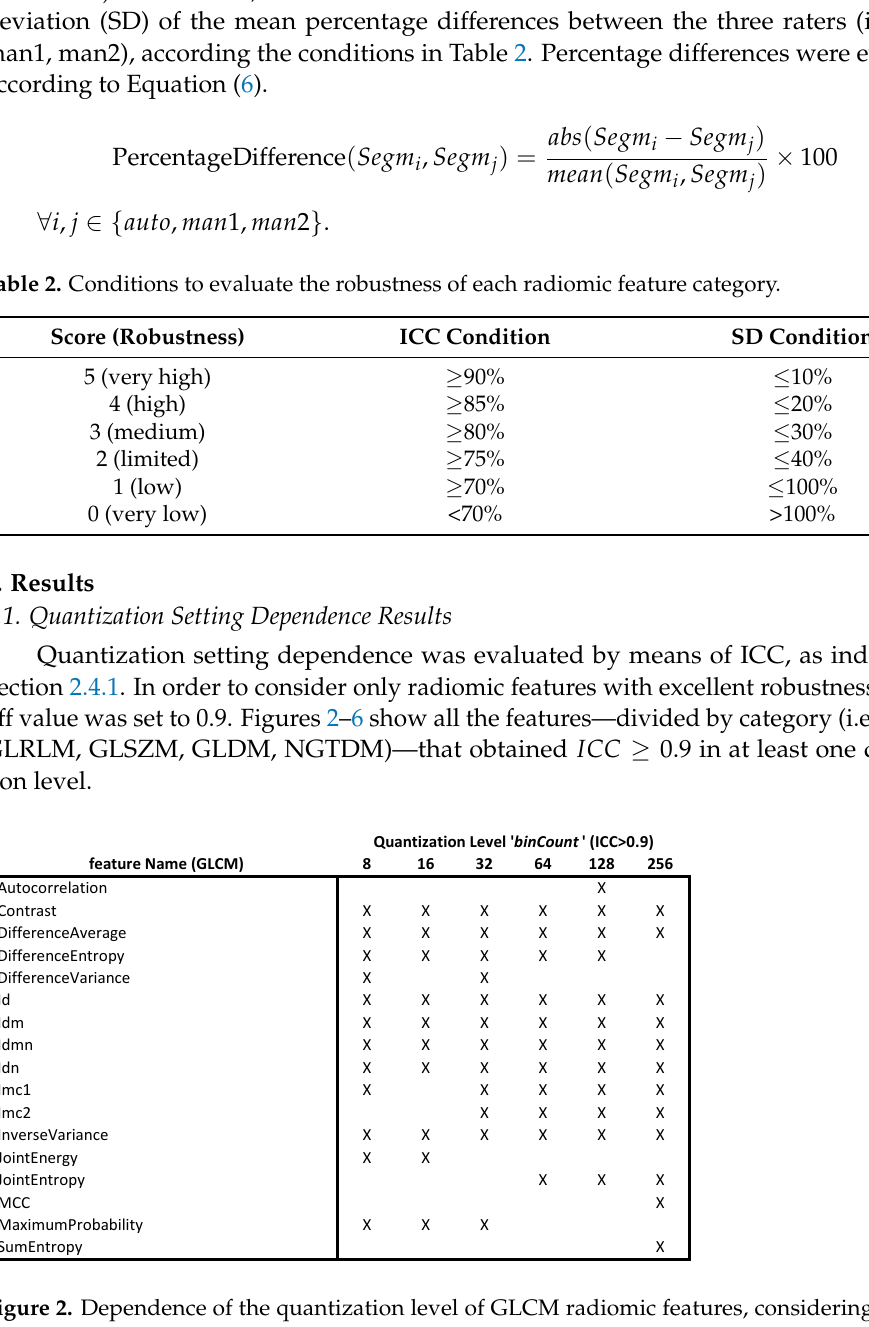
Figure 2. Dependence of the quantization level of GLCM radiomic features, considering different values (i.e., 8, 16, 32, 64, 128, and 256) of the ‘bincount’ PyRadiomics parameter. The features ClusterProminence , ClusterShade , ClusterTendency , Correlation , JointAverage , and SumAverage were discarded, as the ICC did not overcome the cutoff for any ‘binCount’